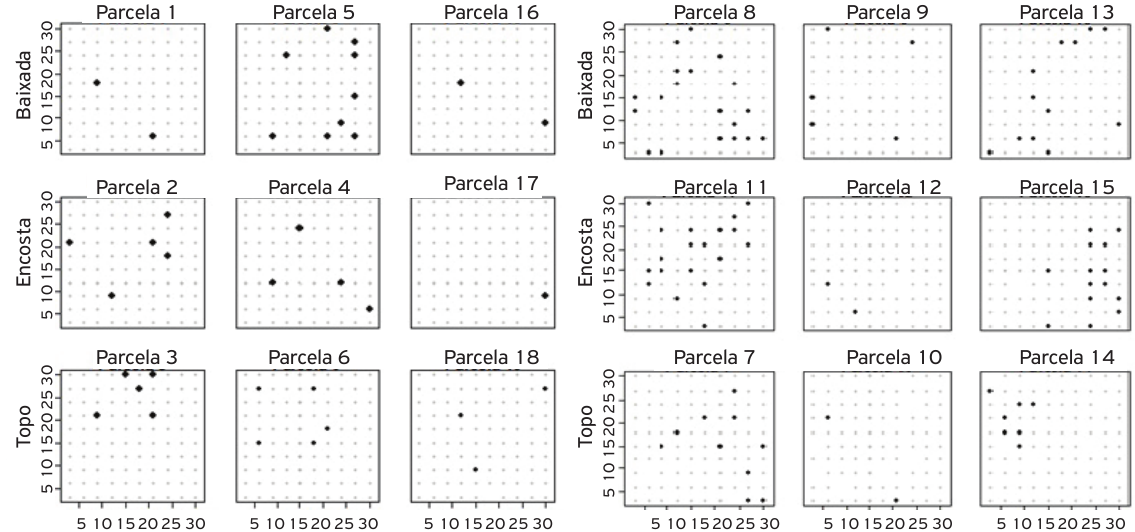
Figura 5. Distribuição do ataque de Heilipodus naevulus (Mannerheim, 1836) em áreas de plantio de clones de eucalipto, plantados sob arranjo espacial de 3 x 3 m, no mês de fevereiro/2009, nos talhões 21 (7 – 12, 16 – 18) e 29 (1 – 6, 13 – 15), subdivididos em baixada, encosta e topo. Barão de Cocais (MG).